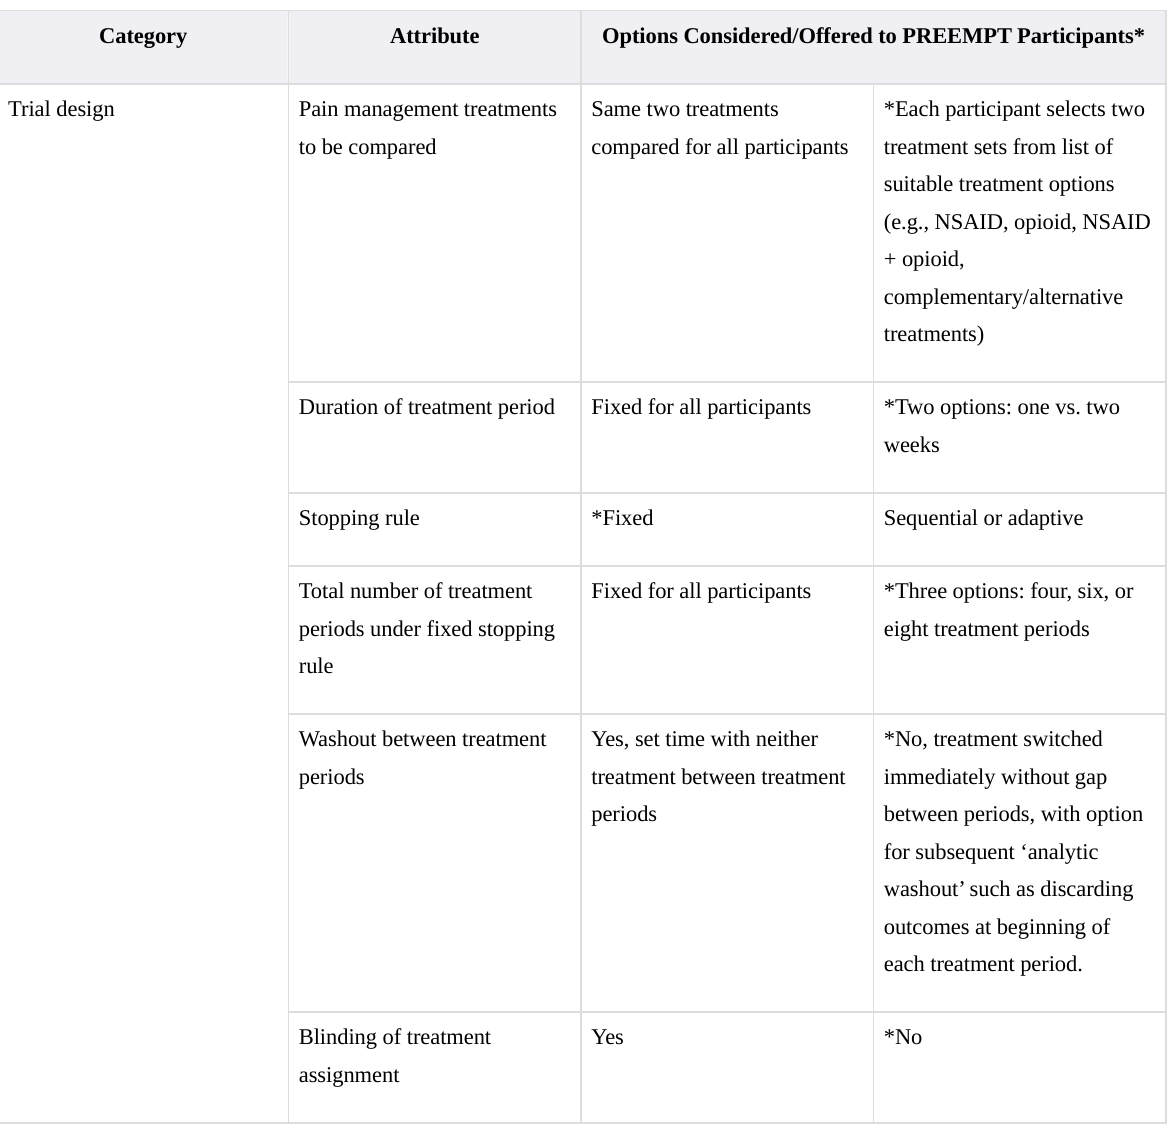
Table 2. Personalization of Per-DS attributes considered in PREEMPT study (Barr, et al. 2015; Kravitz, et al.